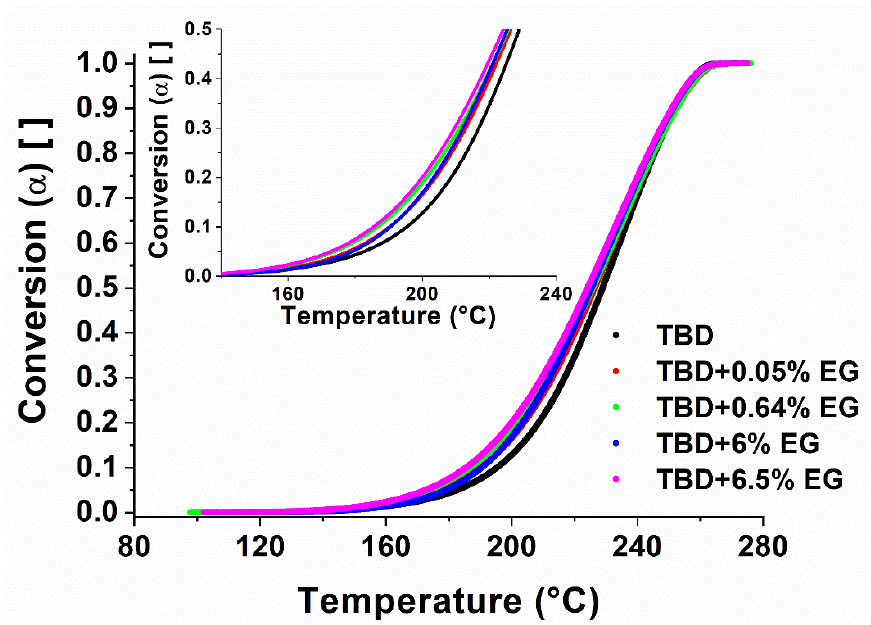
Figure 9. Conversion vs temperature for EG-based epoxy nanocomposites.